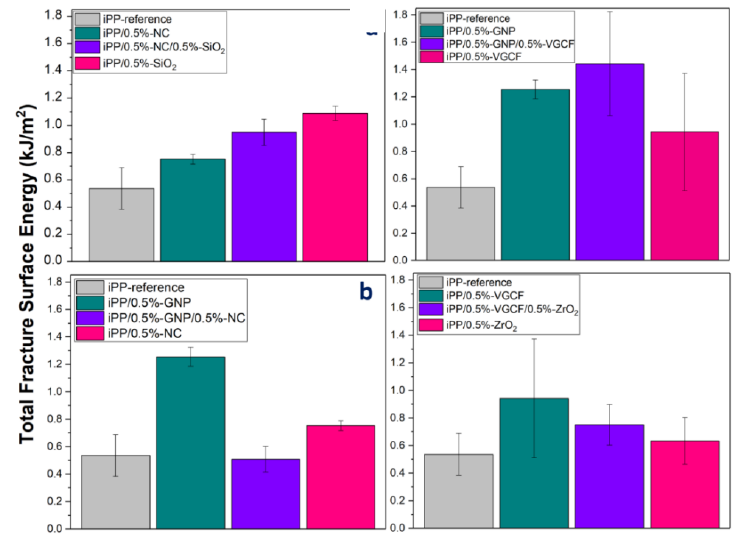
Figure 5. Total fracture surface energies (γ F ) for all the nanocomposites. Each value is an average of at least seven measurements, showing the standard deviations.